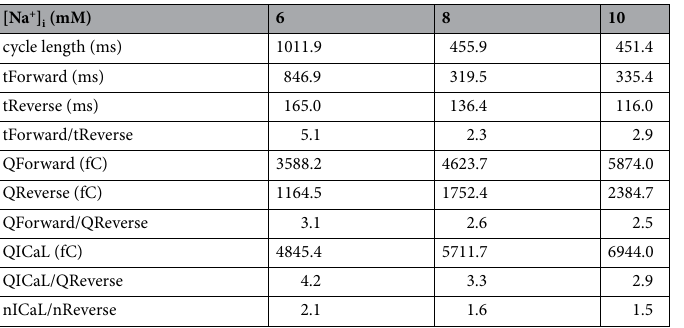
Table 2. Model results for varying levels of intracellular sodium. Cycle length of spontaneous action potential (AP) initiation, time NCX spends in forward (tForward) and reverse (tReverse) mode during each AP, charge carried by NCX in forward (QForward) and reverse (QReverse) mode, carried by I CaL (QICaL) and ratios between them including the ratio of ions carried by I CaL (nICaL) and NCX in reverse mode